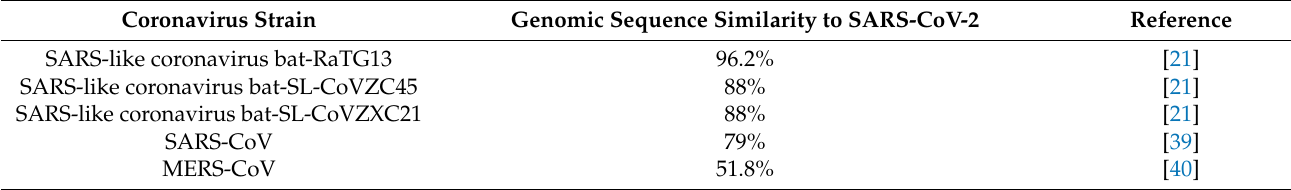
Table 2. SARS-CoV-2 genomic sequence similarity to SARS-like coronaviruses, SARS-CoV and MERS-CoV. Coronavirus Strain Genomic Sequence Similarity to